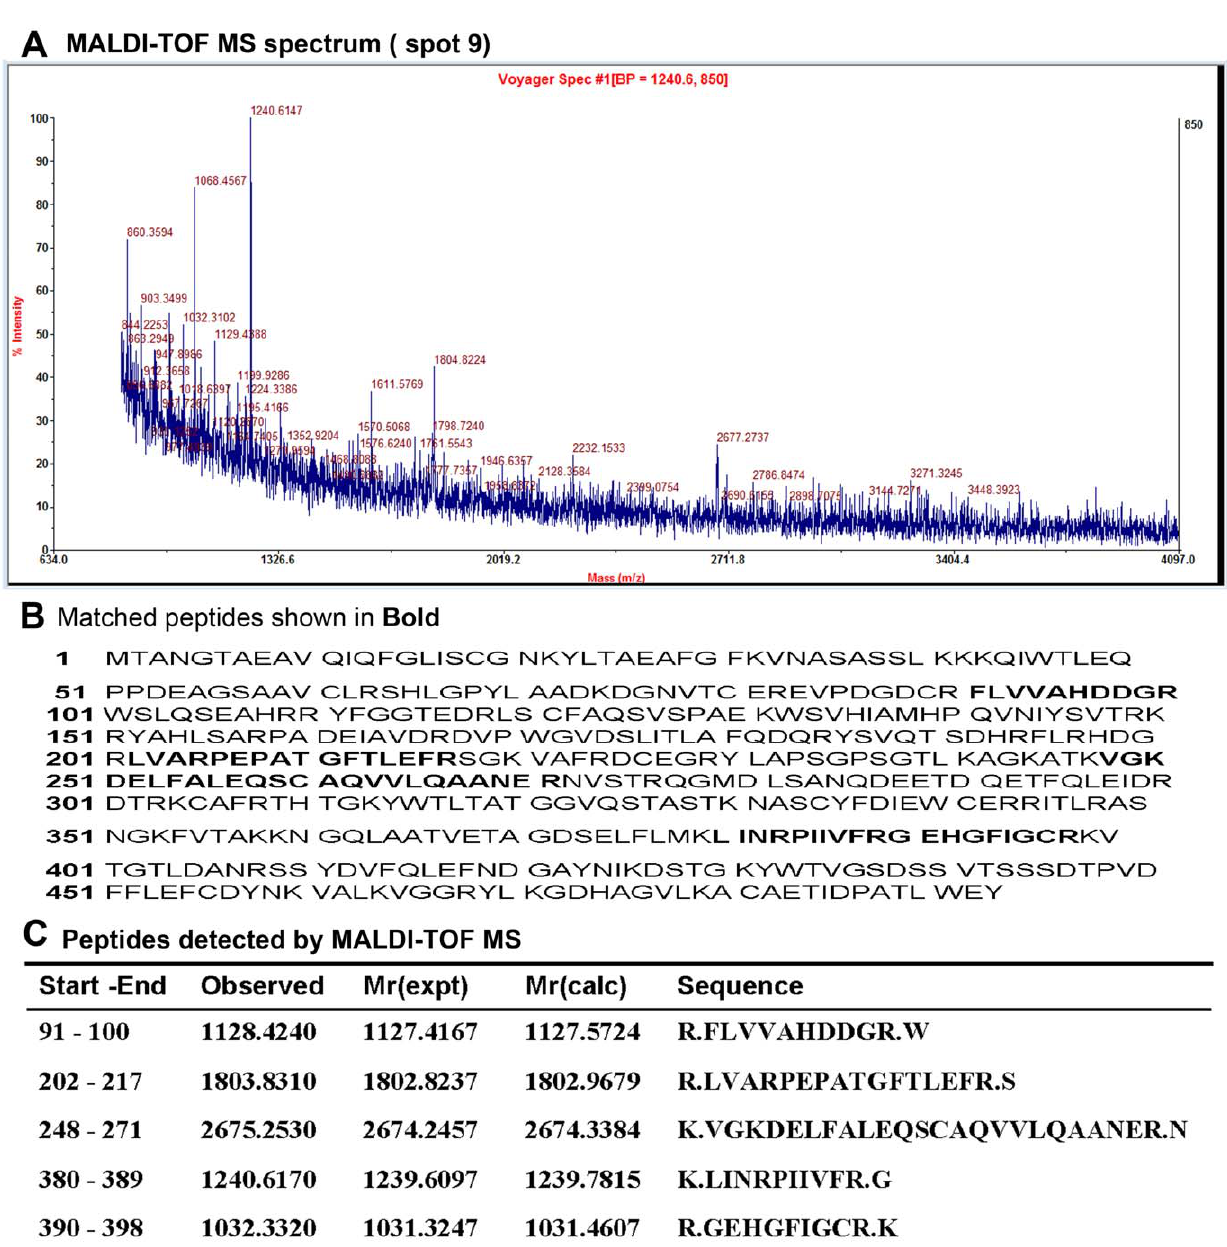
Figure 4. The PMF spectrum obtained using MALDI-TOF MS after tryptic digestion of a representative protein spot (spot 9).